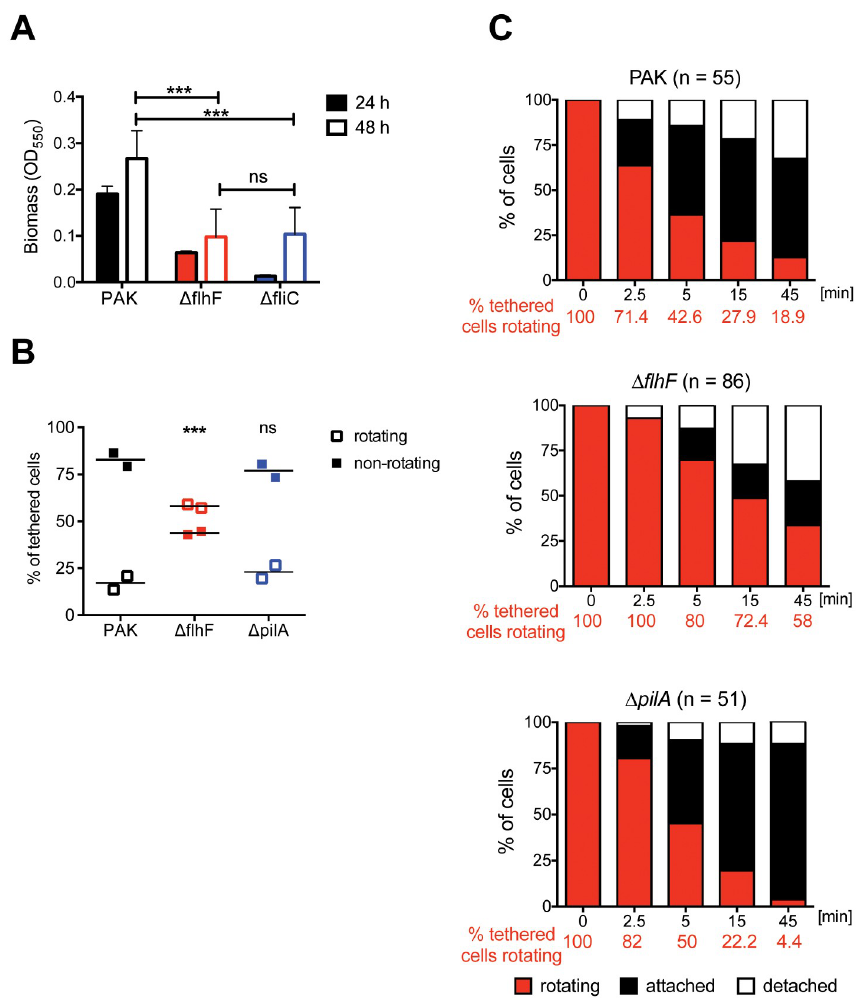
Fig 1. FlhF affects surface behaviors of P . aeruginosa . (A) Δ flhF cells are deficient in biofilm formation . Biomass of static biofilms was measured by crystal violet staining after 24 (solid) and 48 hours (open bars). Bars show mean ± S.D. (n = 4). Both Δ flhF and Δ fliC differ from wild-type PAK ( ��� , p < 0.001), but not from each other (2 way ANOVA with Bonferroni post-test). (B) Δ flhF cells are more likely to rotate after surface tethering . Percentage of rotating vs. non- rotating cells was determined 5 min after tethering to anti-FliC coated slides for PAK (n = 151), Δ flhF (n = 239) and Δ pilA (n = 135) bacteria. Each symbol represents an independent experiment; lines indicate means for each condition. The percentage of rotating Δ flhF cells, but not of Δ pilA , differs significantly from PAK ( ��� , p < 0.001; 2 way ANOVA with Bonferroni post-test). (C) Δ flhF rotation persists over time . Rotating bacteria were identified 5 minutes after tethering to anti-FliC coated slides (t = 0) and observed for 45 min. The proportion of rotating cells (red), attached cells (black), and detached cells (white) was determined in 4–8 independent experiments for PAK, Δ flhF and Δ pilA . Survival curves of rotating cells were analyzed with a Mantel-Cox test. The percentage of rotating Δ flhF cells differed from PAK or Δ pilA ( ��� , p < 0.0001); the percentage of rotating PAK v Δ pilA cells did not differ significantly ( p =